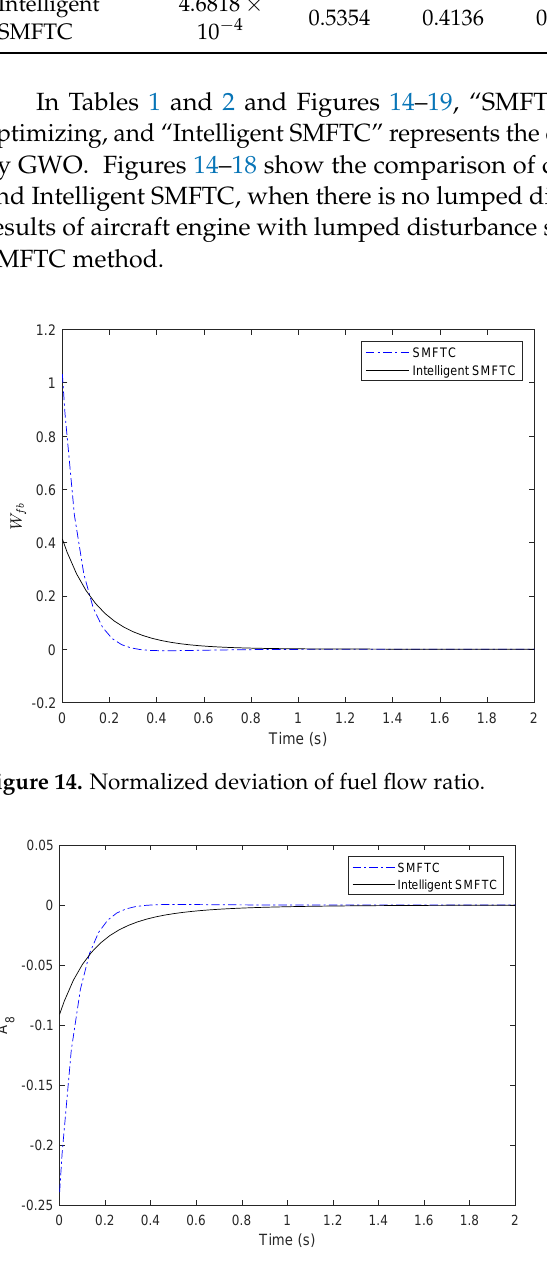
Figure 15. Normalized deviation of nozzle throat